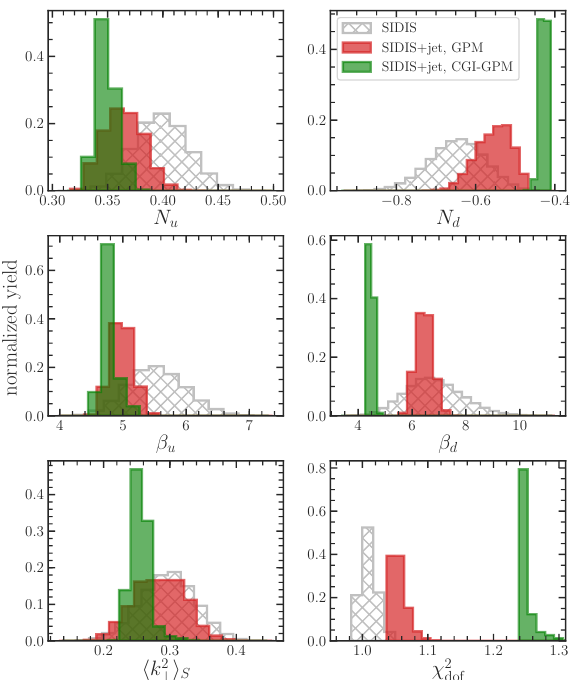
Figure 2: Parameters and χ 2 probability densities. Hatched histograms refer to the dof priors coming from SIDIS data only. Color code is the same as in Fig. 1.